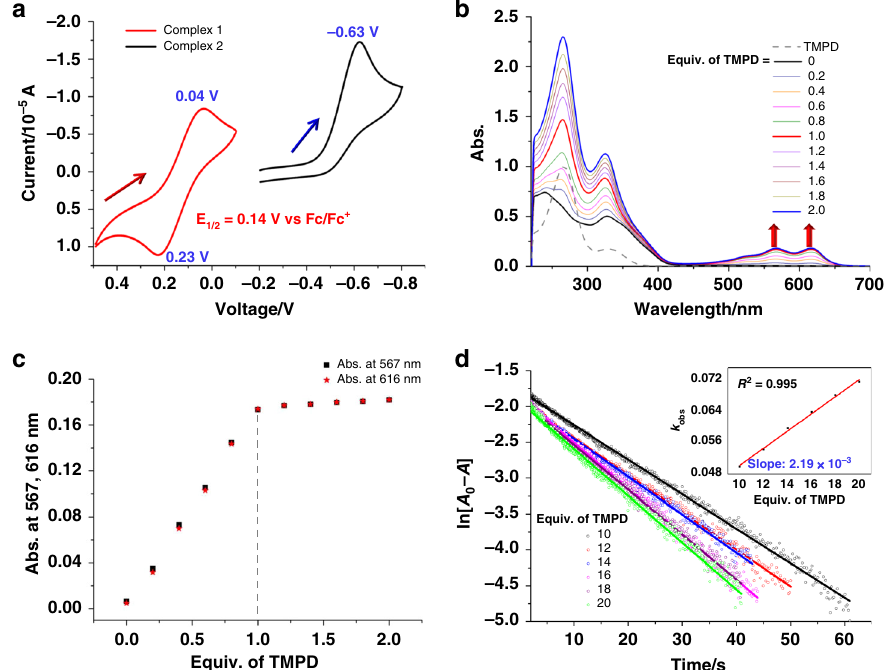
Fig. 4 CV, UV-vis titration and kinetic studies. a CV curves of 1 and 2 (0.5 mM) in deaerated acetone (0.1 M Bu 4 NPF 6 ) at 298 K with a glassy carbon working electrode and a Ag/AgCl reference electrode. Scan rate: 100 mV s − 1 . All potentials were measured against the Fc/Fc + redox couple. b Titration of 1 (0.6 mM) with TMPD monitored by UV-vis spectroscopy. c Characteristic absorbance at 567 and 616 nm upon adding different equivalents TMPD. d Pseudo- fi rst-order plots of the TMPD-to- 1 electron transfer in acetone at 298K. (Inset) Determination of k et (298 K) by the plot of the pseudo- fi rst-order rate constants ( k obs ) versus the concentrations of TMPD